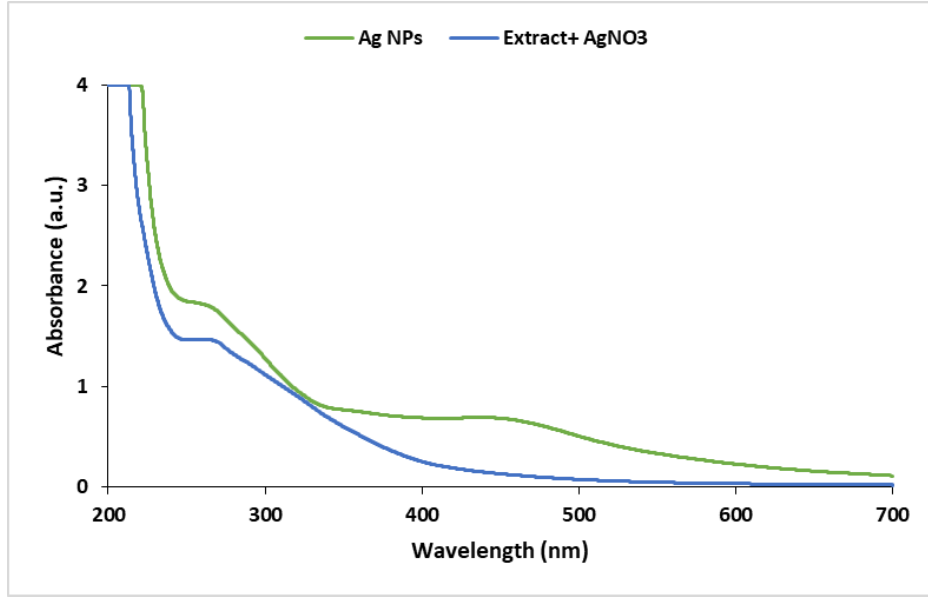
Figure 6. UV-visible spectrum of Ag nanoparticles, and the mixture of AgNO 3 and plant extract.